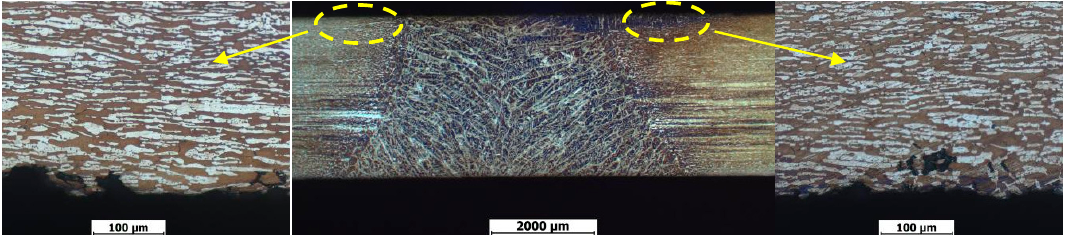
Figure 14. Cross section morphology of untreated sample after corrosion test.